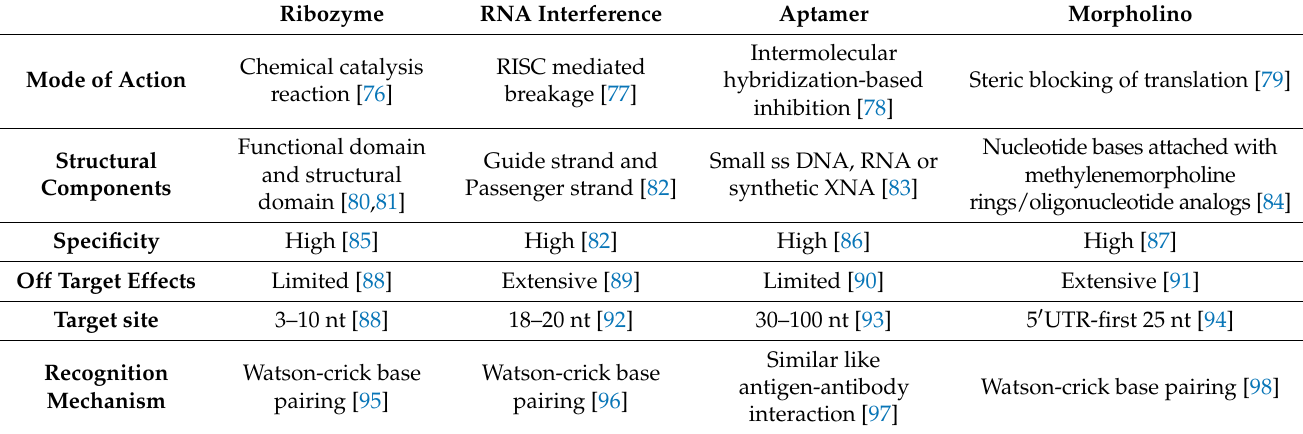
Table 1. An overview of key differences between different oligonucleotide-based antiviral approaches against